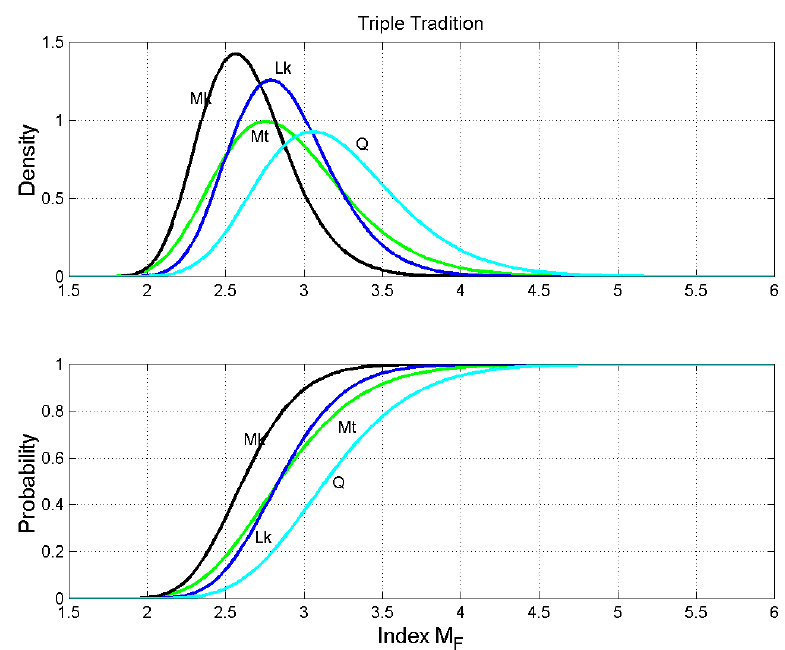
Figure 6. Triple Tradition and Q. Probability density functions (upper panel) and probability distribution functions (lower panel) of the number of words per sentence 𝐶 𝑃 . Matthew : green line; Mark: black line; Luke : blue line; Q : cyan line.